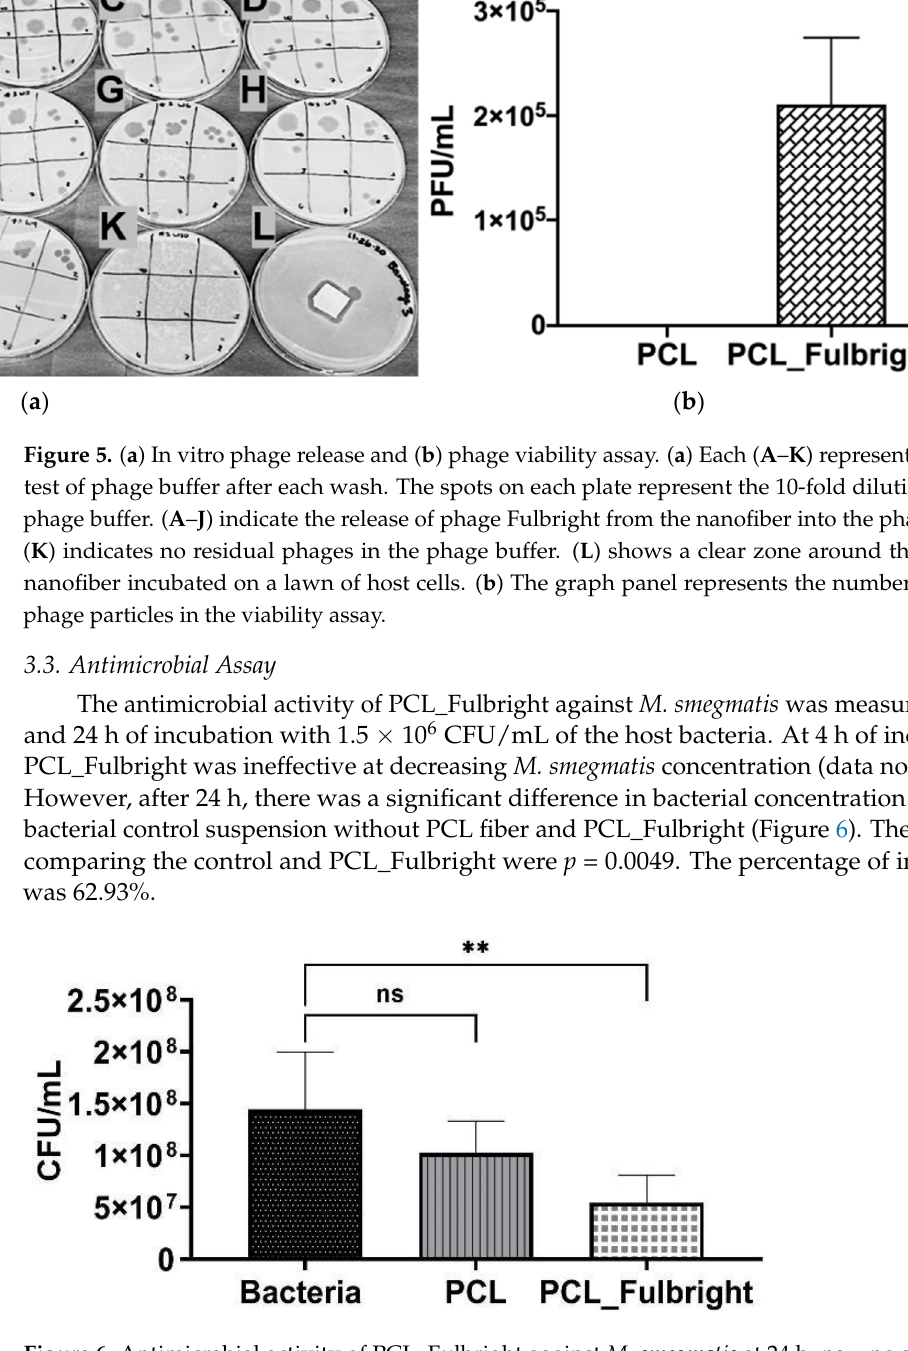
Figure 6. Antimicrobial activity of PCL_Fulbright against M. smegmatis at 24 h. ns = no significant difference and ** p value <